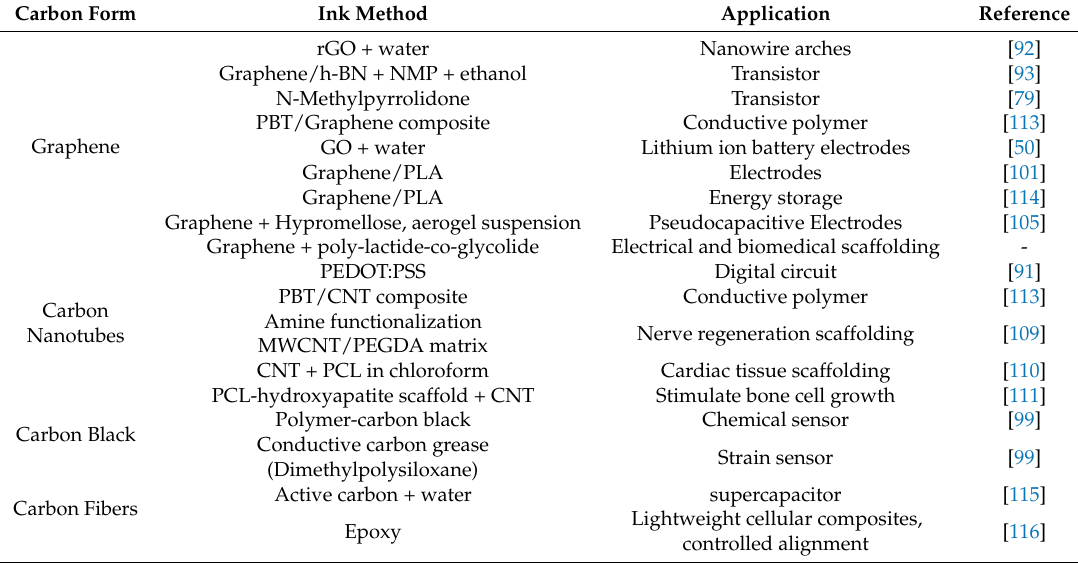
Table 8. Summary table for possible applications for carbon-based